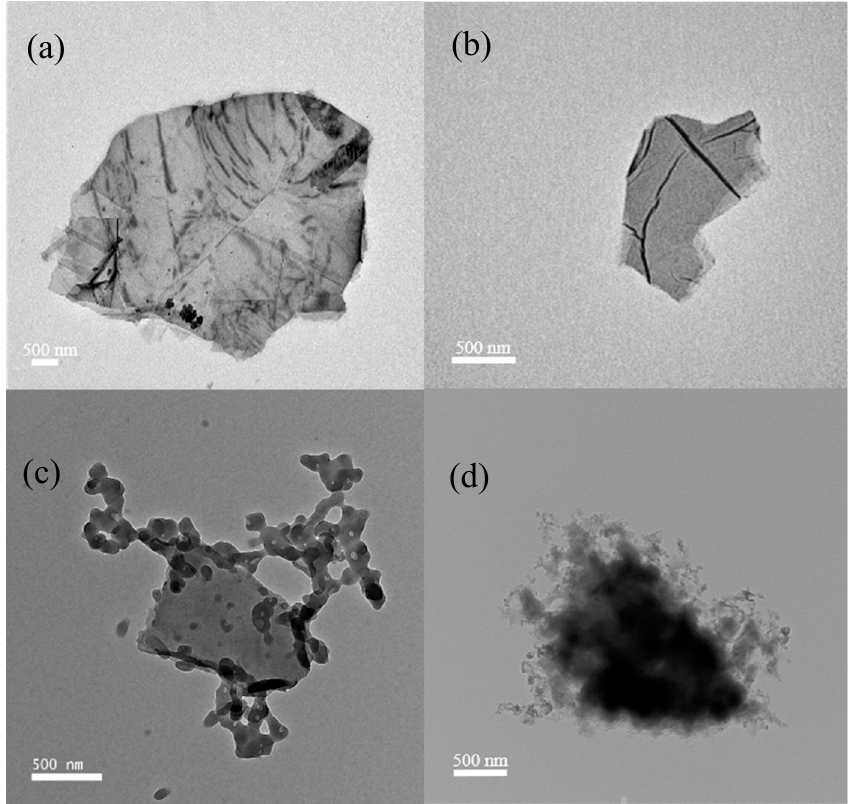
Figure 1. TEM images of ( a ) GNS, ( b ) GO, ( c ) GO- g -PTA-F, and ( d ) GO- g -PTA-A.